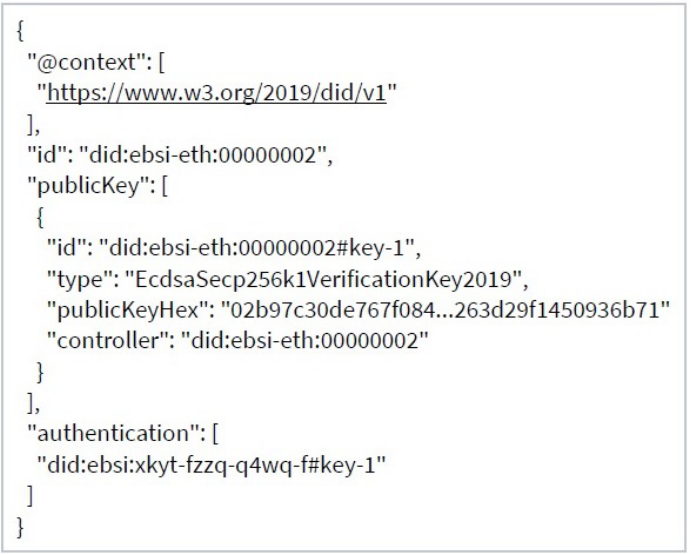
Figure 6. ESSIF DID